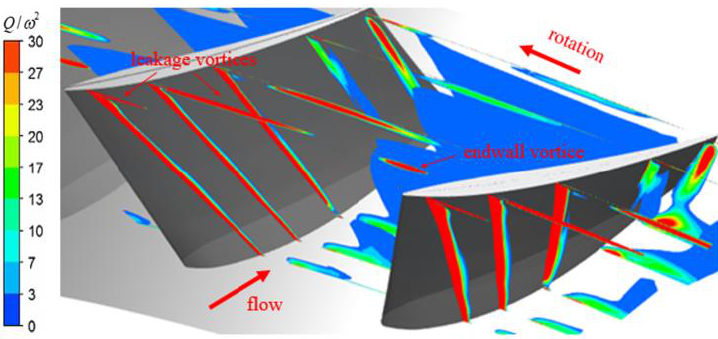
Figure 9. Relative Q-criterion contour of S_A_120700Pa_R1.